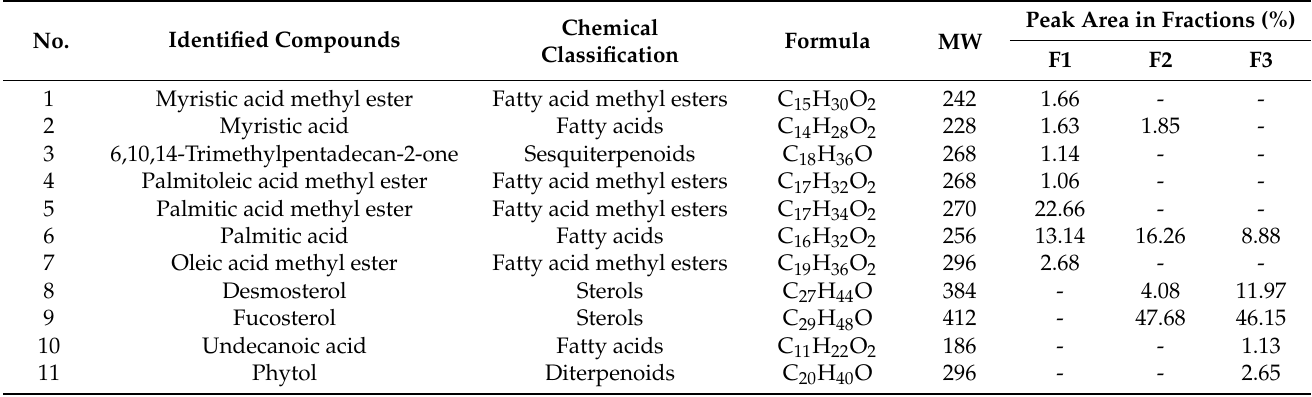
Table 4. Bioactive components of the fractions (F1, F2, and F3) from Sargassum spp.